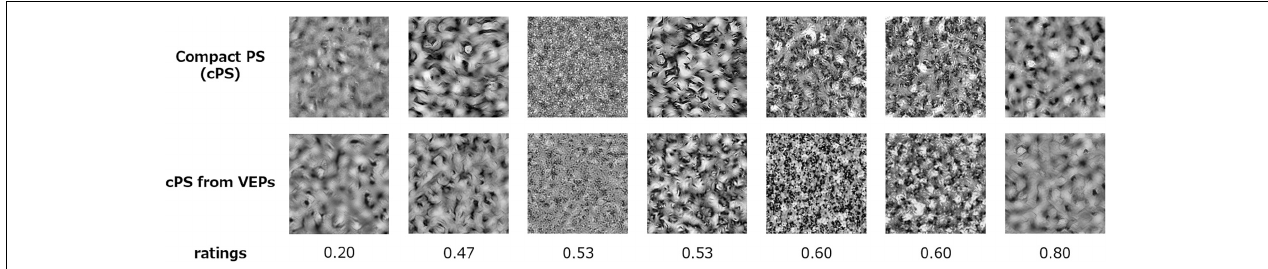
FIGURE 6 | Compact Portilla–Simoncelli (cPS) synthesized textures and compact-PS-synthesized textures with the image statistics as estimated from VEPs. The perceptual dissimilarity ratings (0–4) are given below the images.